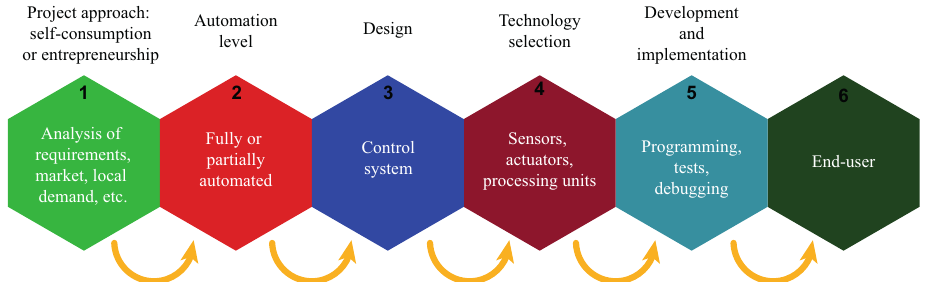
Figure 5. Steps for the integration of technology in small-scale food production systems based on the farmer’s